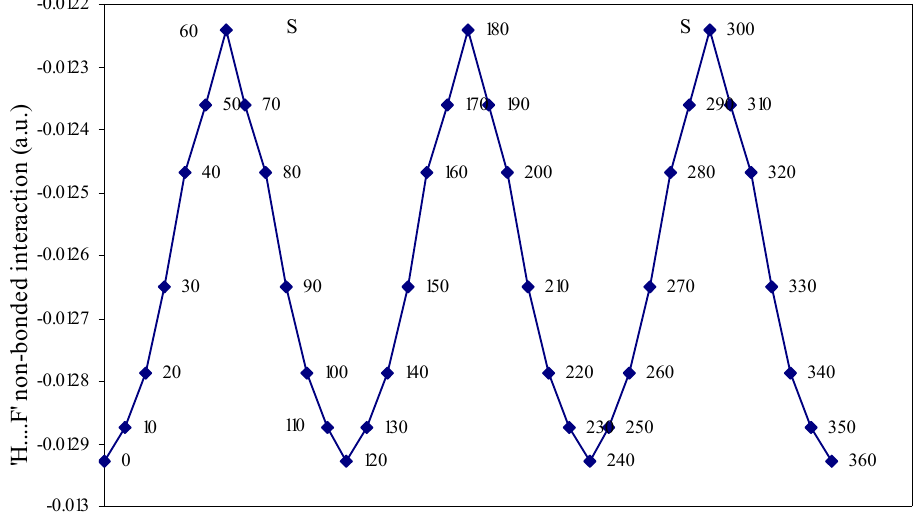
Figure 8. Plot of 'H.···F' non-bonded interaction of F torsional angle (E-Eclipsed, S-Staggered)